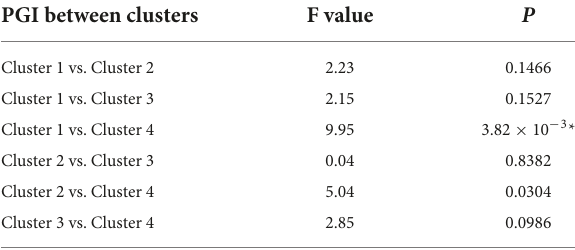
TABLE 5 Compare the PGI and lesion size between shape clusters in the S l group.